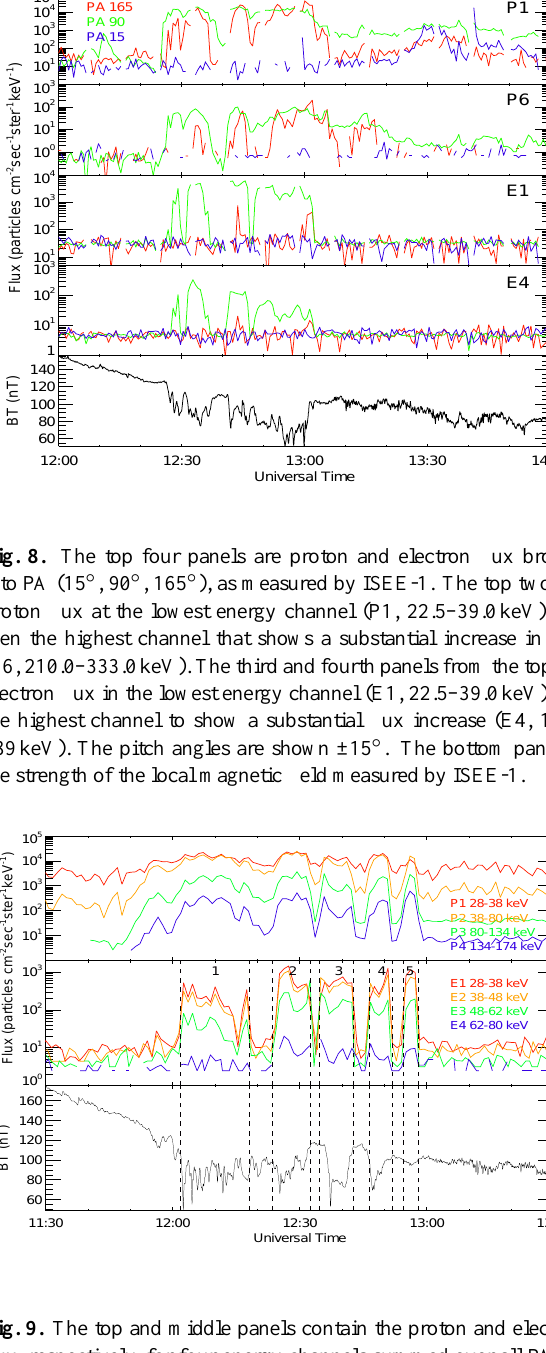
X =0.95 − 4.75 R E , Y =27.81 − 26.91 R E , Z = − (15.23 − 18.25) R E . It also showed the B x , B y and B z components of the IMF to be negative, positive and negative, respectively, with similar magnitudes as measured by ISEE-3 (Fig.